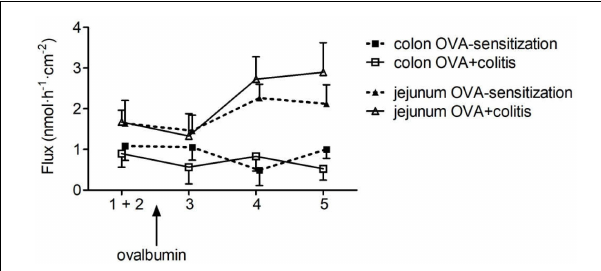
FIGURE 3 | Flux of fluorescein from the mucosal to the serosal side in five sequential 30 min periods in rat jejunum (triangles) and colon (squares) of OVA-sensitized animals with (open symbols) or without (filled symbols) prior induction of a colitis. After determination of basal fluorescein flux in two control periods, which were pooled for statistical analysis (period 1 + 2), ovalbumin (100 µ g · ml − 1 ) was administered at the mucosal and serosal side and the fluorescein flux was measured in three further 30 min periods (period 3–5). For graphical clarity, data were laterally shifted and SEM is only given as +SEM or -SEM to avoid overlay of the symbols. Data expressed as mean (symbols) + or − SEM (vertical lines), n =